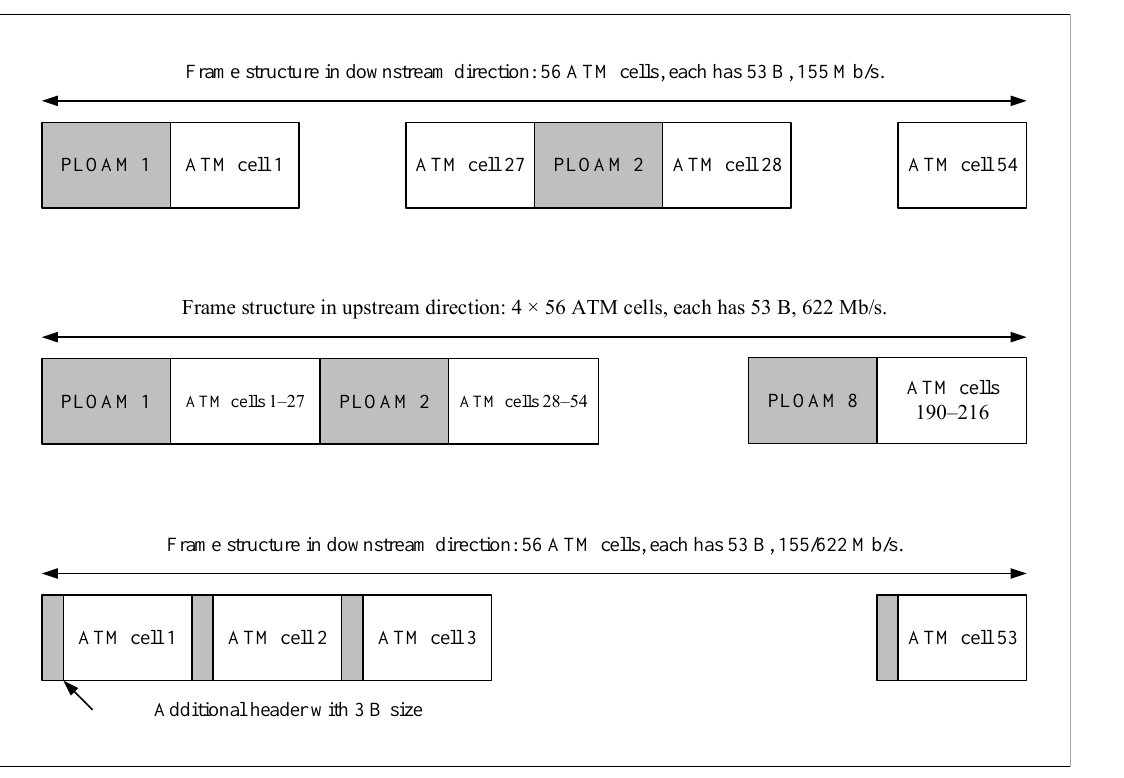
Figure 3. Structure of asynchronous transfer mode passive optical network (APON) frames